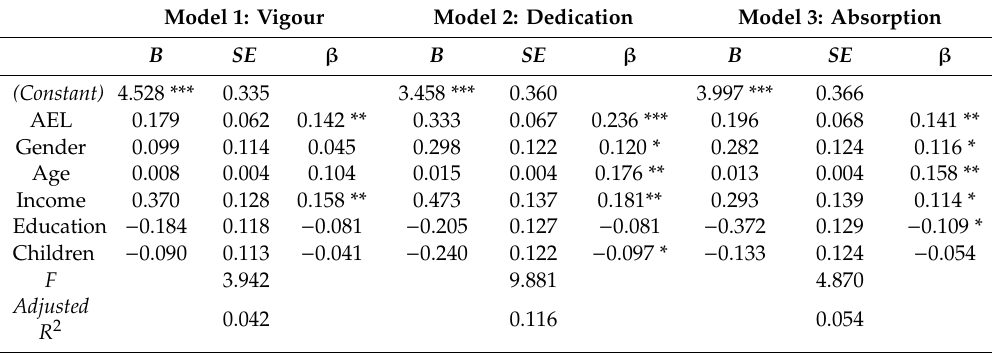
Table 3. The dimensions of work engagement and supervisors’ active-empathetic